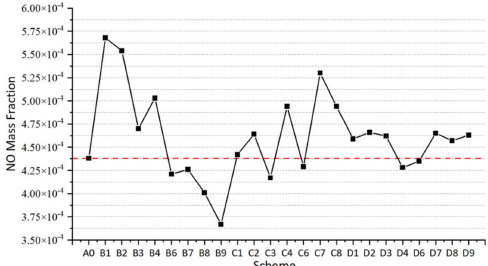
Figure 47. NO mass fraction distribution of each optimized design scheme.